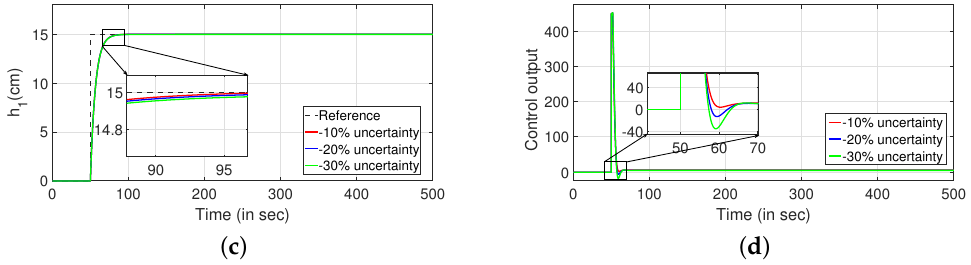
Figure 18. Reference tracking of Equation (43) for ± 10%, ± 20% and ± 30% uncertainties. ( a ) Level Variation in tank 1. ( b ) Control output. ( c ) Level Variation in tank 1. ( d ) Control output.